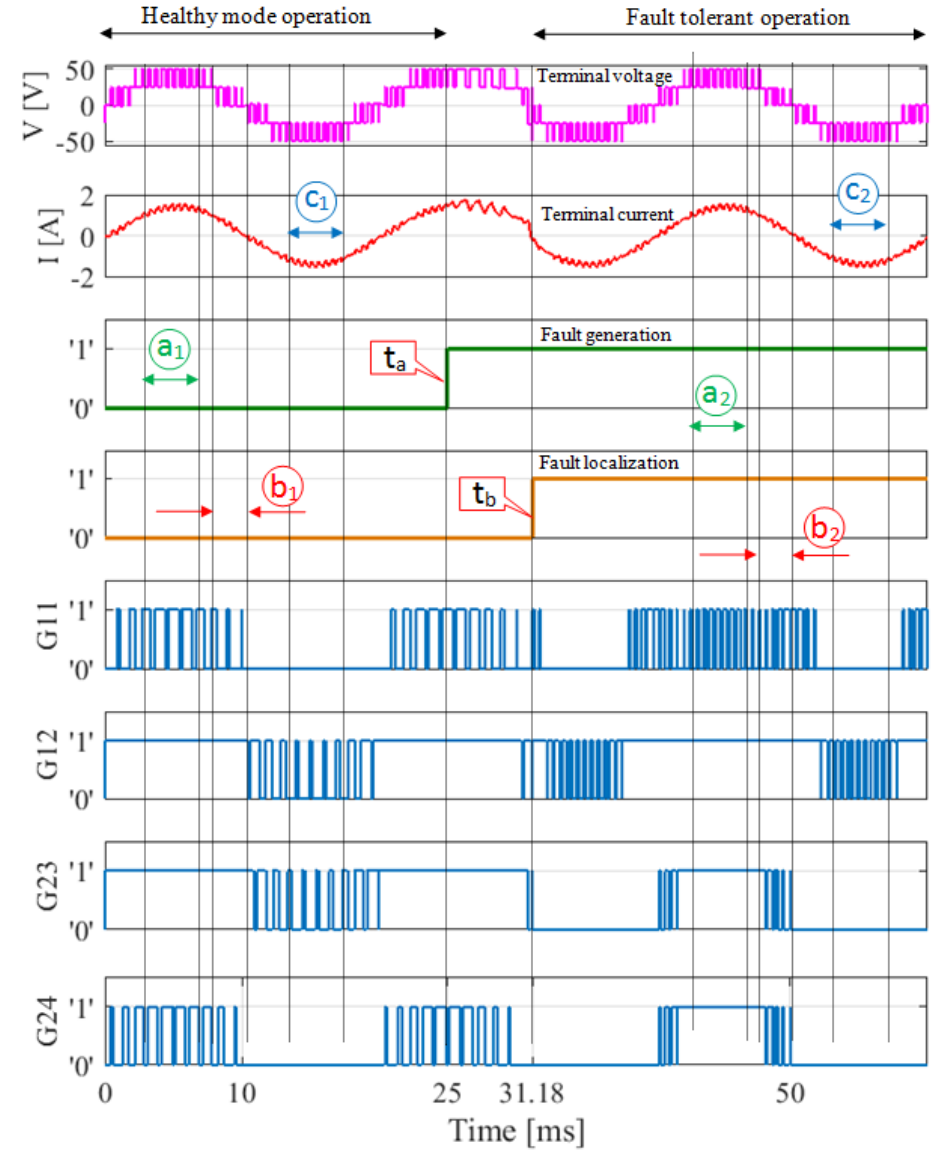
Figure 11. Simulation results for fault-tolerant operation of the inverter in the case of a short-circuit fault event in S24. Table 7. Applied switching states corresponding to each interval in Figures 8–11.